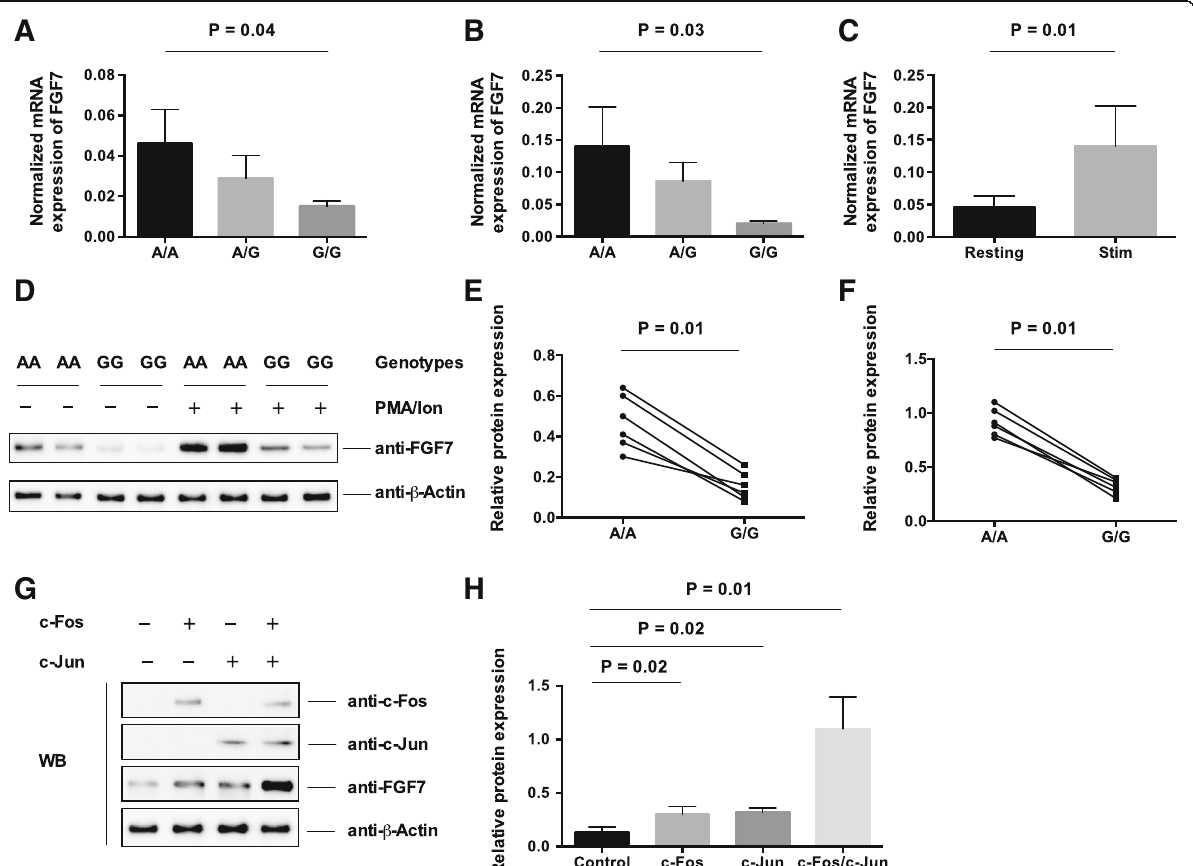
Fig. 3 Overexpression of AP-1 transcription factors or stimulation with PMA/Ionomycin increases expression of the FGF7 gene in fibroblast cells. a and b Messenger RNA expression of the FGF7 gene in fibroblast cell lines carrying various genotypes at the variant rs12905203 at resting- and stimulated-conditions. c mRNA expression of the FGF7 gene in fibroblast cell lines at resting and stimulated conditions. d Protein expression of the KGF in fibroblast cell lines carrying homozygous risk and non-risk variants was determined using western blotting with an anti-KGF antibody. e and f The protein expression of KGF in fibroblast cell lines were normalized to the beta-actin controls for resting- ( e ) and stimulated ( f ) conditions. Three independent experiments were performed, and the differences in protein expression of the KGF were calculated by paired Student ’ s t-test. g Fibroblast cells were transfected with c-Fos, c-Jun, or c-Fos/c-Jun expression vectors. The expression of the KGF protein was determined by western blotting with an antibody against KGF. h We performed densitometric quantification of c-Fos, c-Jun, and KGF in three independent experiments. The statistical differences between groups were calculated by using Student ’ s